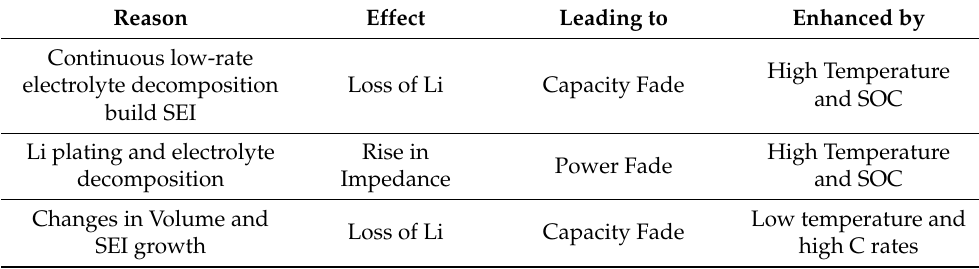
Table 3. Surface Effect on the Negative